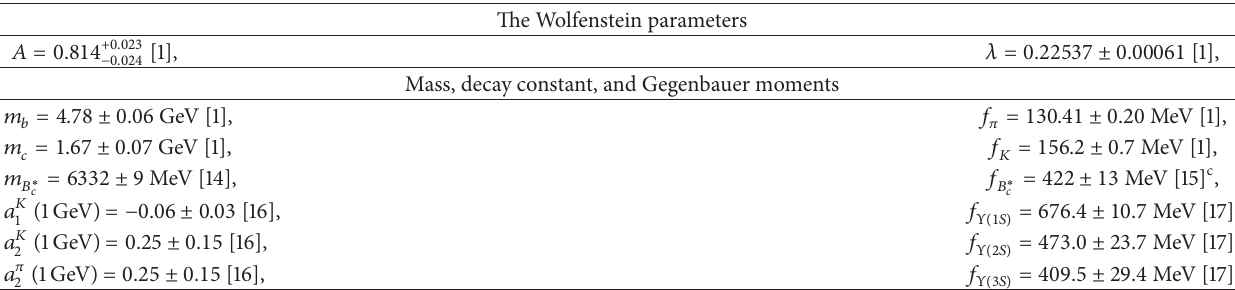
Table 2: The numerical values of input parameters.